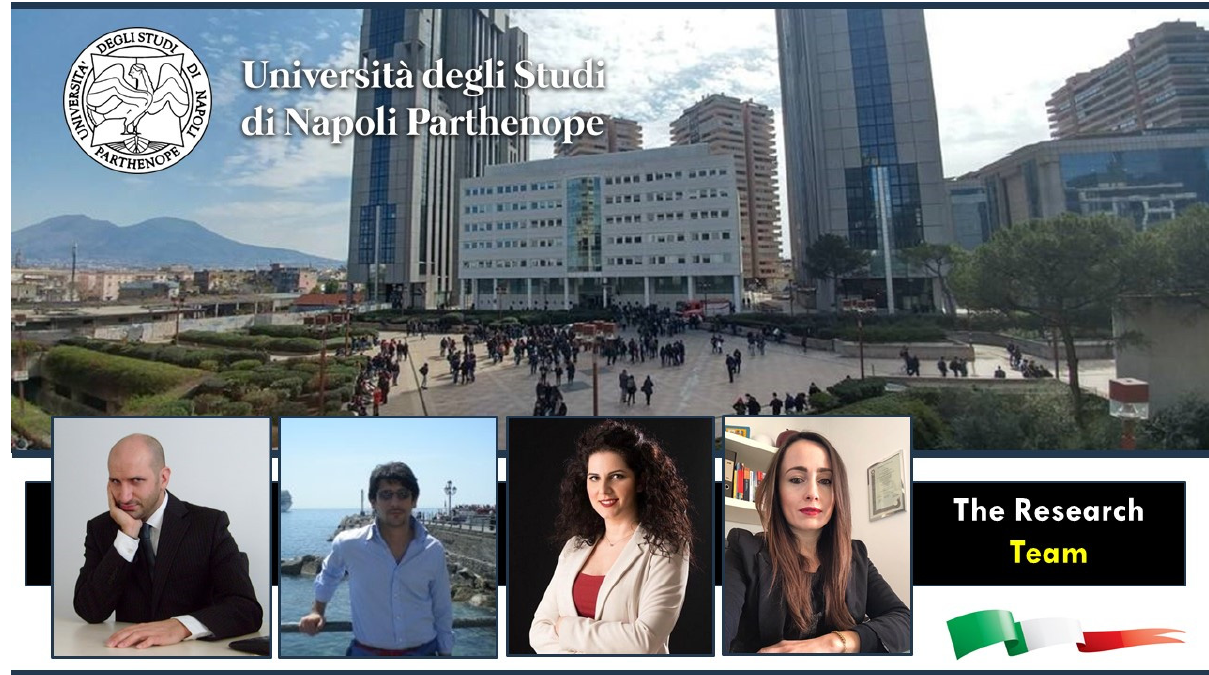
Figure 2. Research Group at Department of Engineering—University of Napoli “Parthenpe”, Italy (Francesco Colangelo, Antonio Forcina, Ilena Farina, Antonella Petrillo).